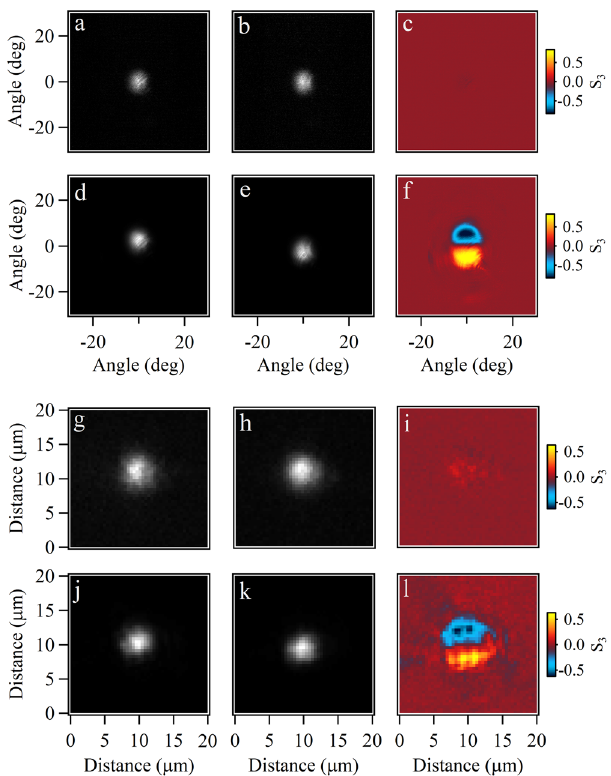
Fig. 4 Rashba-Dresselhaus effect on polariton condensates in far- fi eld (upper) and near- fi eld (lower). a Left- and ( b ) right-hand circularly polarized momentum space imaging at 0 V. d Left- and ( e ) right-hand circularly polarized momentum space imaging at 4.5 V. c , f Circularly polarized imaging corresponding to ( a , b ) and ( d , e ), respectively. g – l Corresponding real-space imaging of the polariton condensate to ( a – f ), respectively.